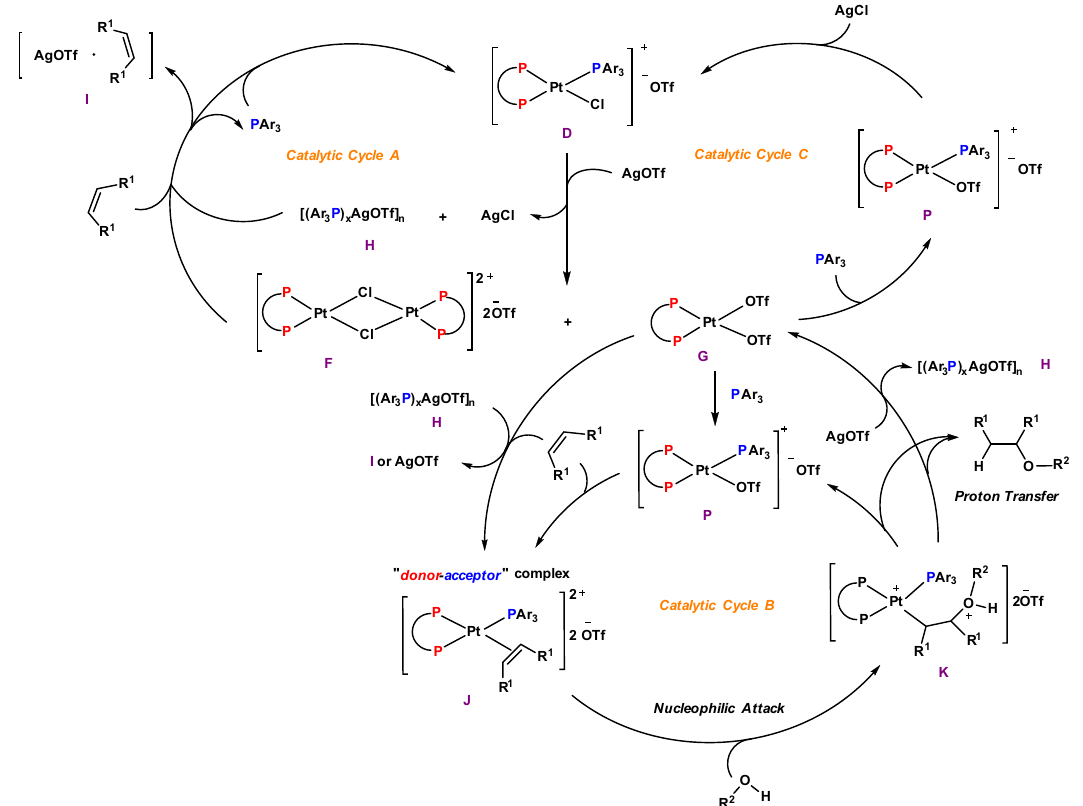
Fig. 10 Proposed mechanism for “ donor – acceptor ” Pt complex catalyzed hydroalkoxylation of unactivated alkenes. Speci fi cally, D : Catalyst; F : a dinuclear intermediate after Pt – P bond dissociation; G : an intermediate after Pt – Cl and Pt – P bonds dissociation; H : a silver-phosphine complexe; I : a silver- alkene complexe; J : an alkene-bound Pt (II) intermediate; K : transition state for nucleophilic attack of an alcohol to complex J ; P : an intermediate after Pt – Cl bond